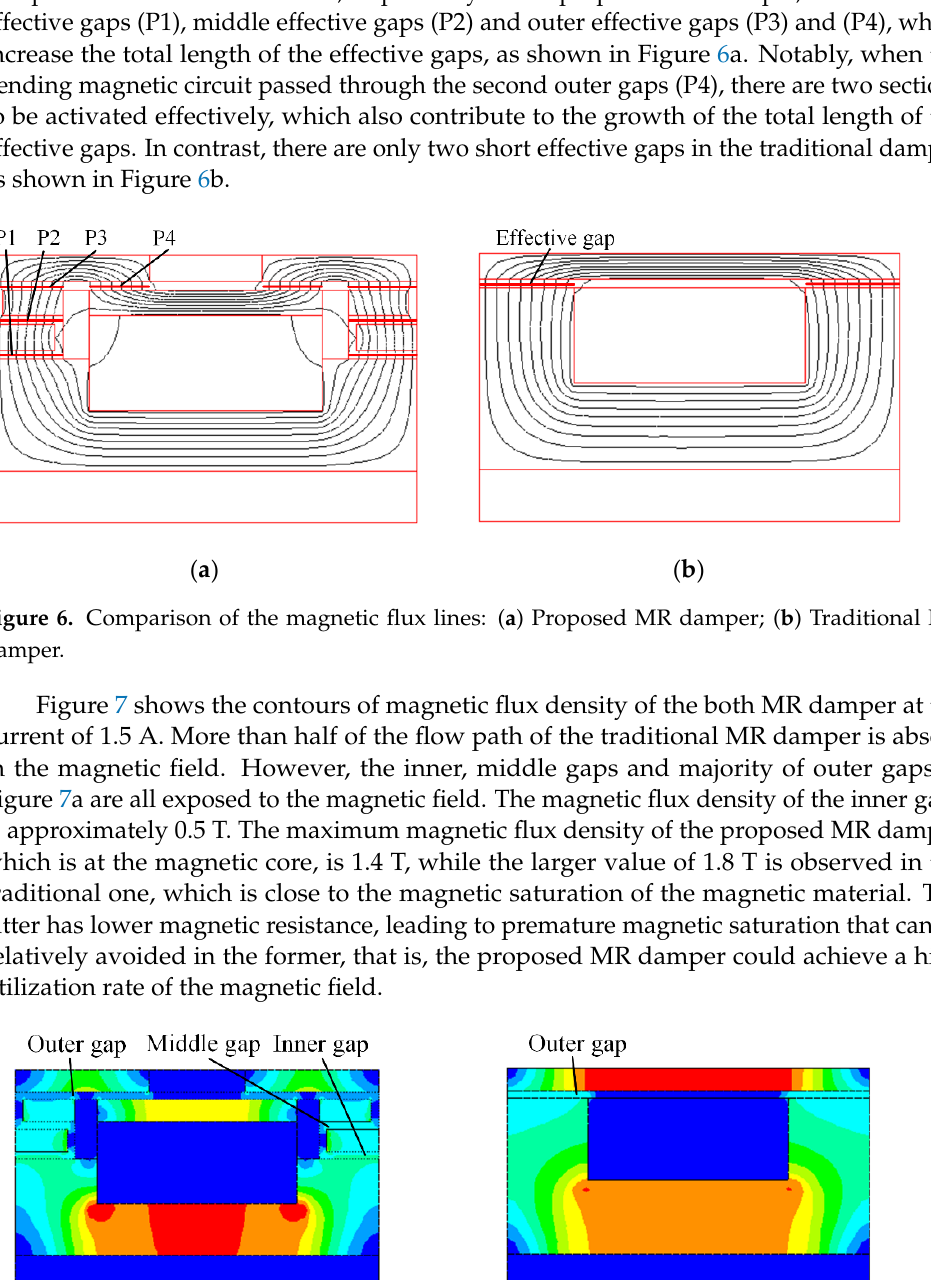
Figure 5. Axisymmetric model for the FEA: ( a ) Proposed MR damper; ( b ) Traditional MR damper.